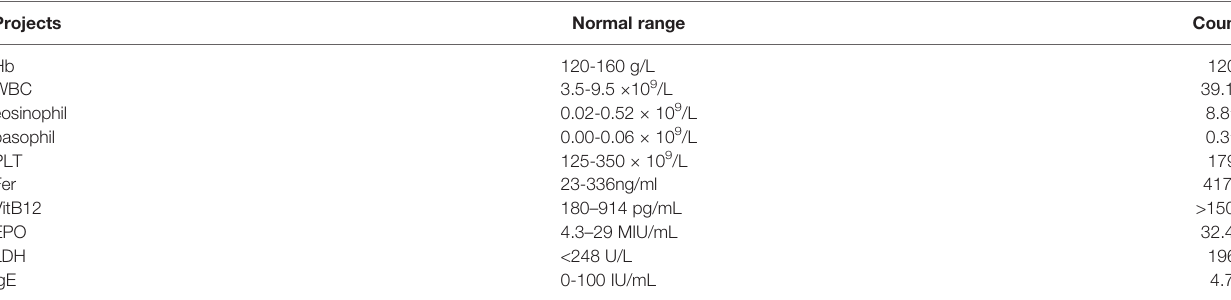
CBC, complete blood count; Hb, hemoglobin; WBC, white blood cell; PLT, platelet; Fer, ferritin; VitB12, vitamin b12; EPO, erythropoietin; LDH, lactate dehydrogenase. ↑ ,